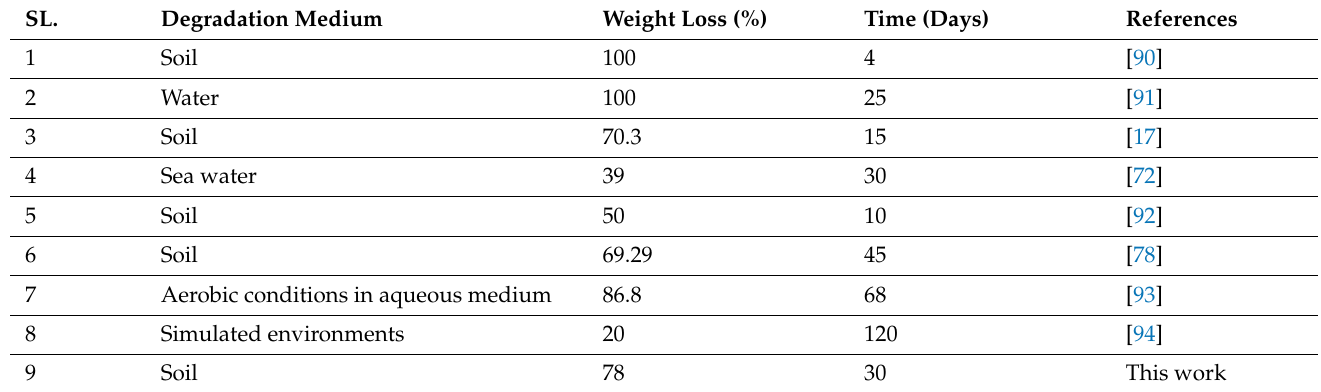
Table 6. Biodegradation of different bioplastic samples found in the literature.